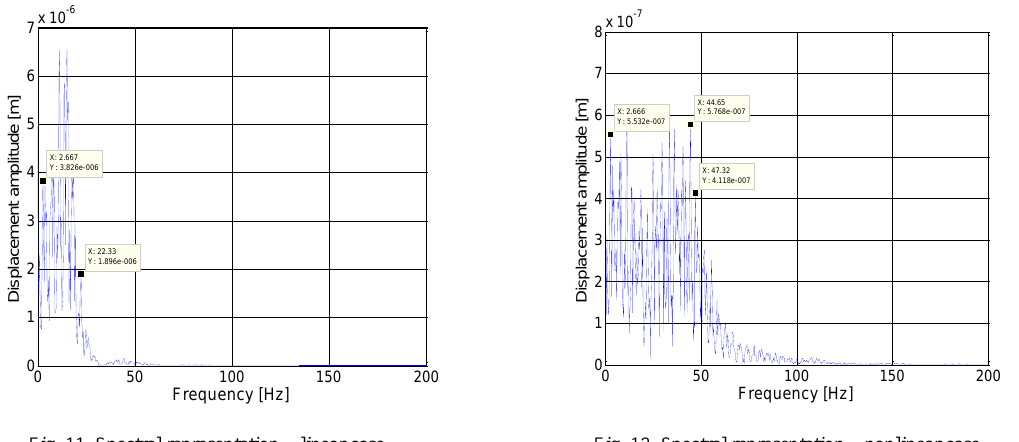
Fig. 11. Spectral representation – linear case. Fig. 12. Spectral representation – nonlinear case.